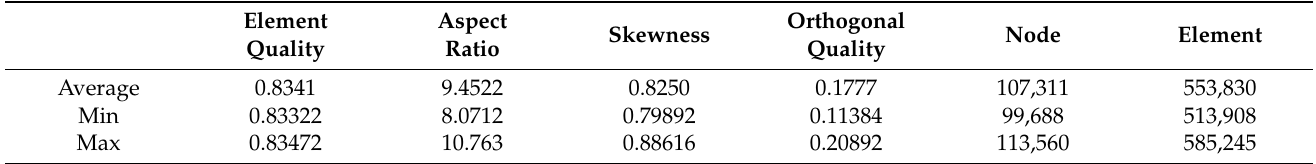
Table 5. Mesh quality applied to structure